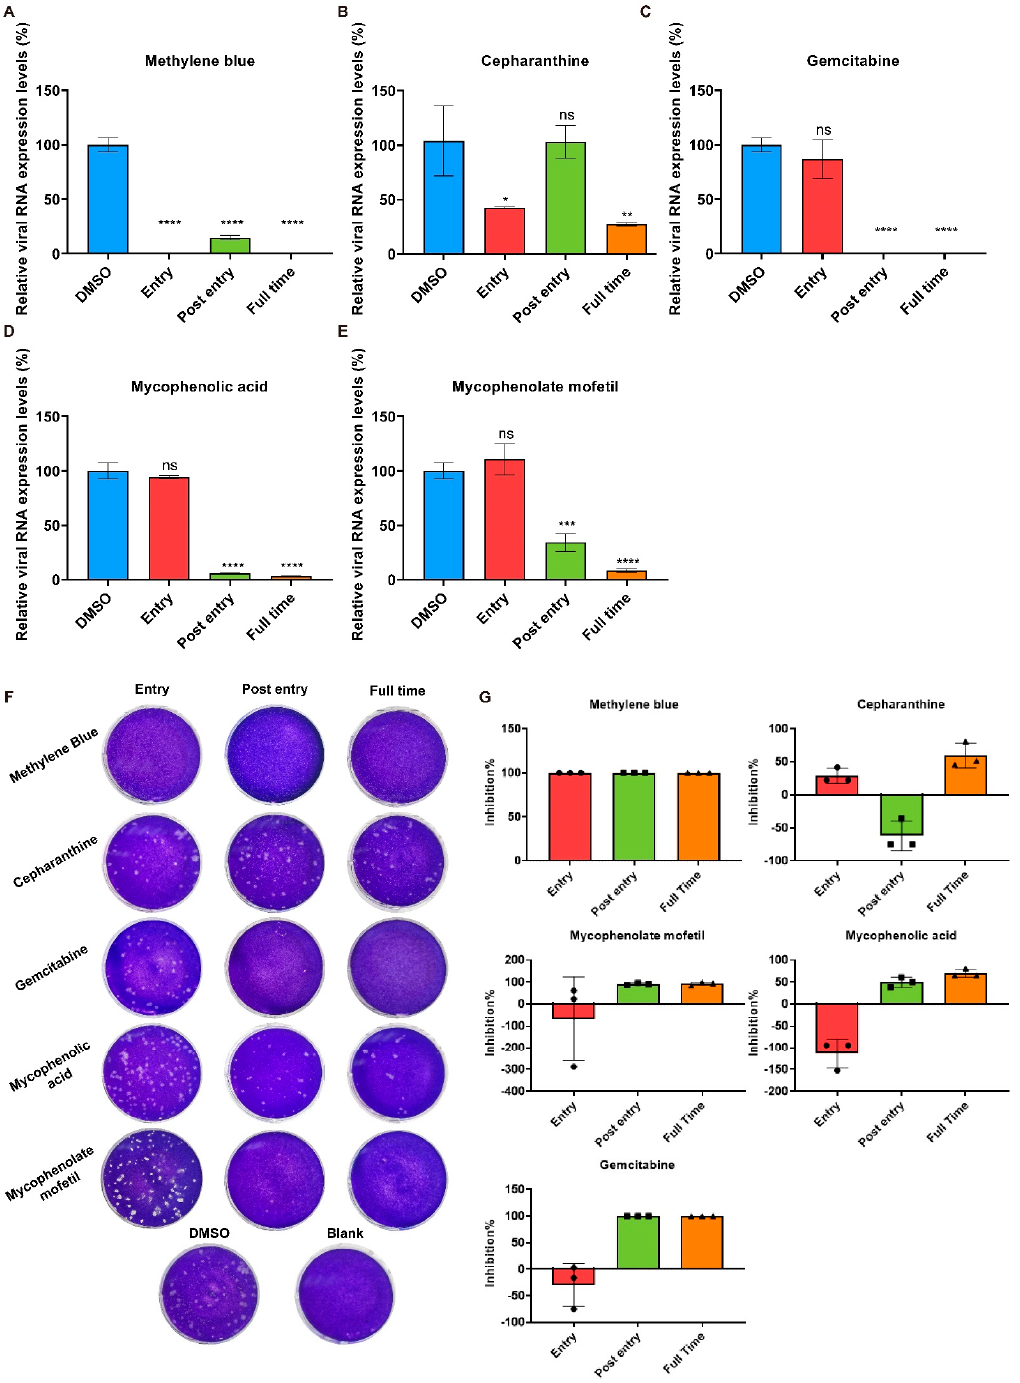
Figure 4. Preliminary identification of potential antiviral targets. Methylene blue (1.5625 µ M), mycophenolate mofetil (12.5 µ M), mycophenolic acid (12.5 µ M), gemcitabine (6.25 µ M), and cepha- ranthine (6.25 µ M) were separately tested through the time-of-addition assay. qPCR and plaque assay were used to examine viral RNA expression levels in the cells ( A – E ) and infectious progeny in the supernatant ( F ), respectively. The viral titers in the supernatant were quantified and used to calculate the inhibition rates ( G ). DMSO was added as the positive control and the RNA expression levels were normalized to the positive control. The shown results are representative of one experiment out of at least two experiments. Error bars represent ± 1 SD; ns, no significant difference; * p < 0.05, ** p < 0.01, *** p < 0.001, **** p < 0.0001 by Student’s t